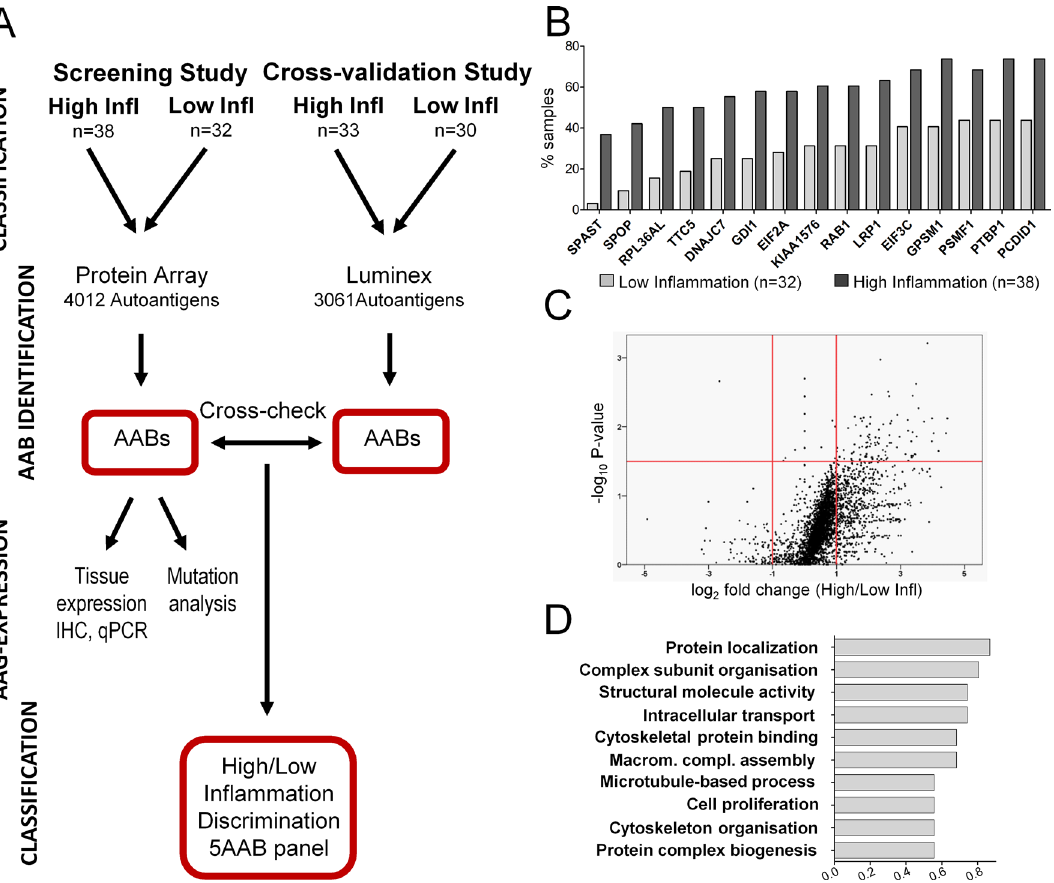
Fig 1. Chronic prostatic inflammation induces elevated autoantibody levels. A Flow chart of the strategy used for the detection and cross-validation of autoantibody (AAB) signatures associated with chronic prostatic inflammation. Radical prostatectomy specimens were classified into two (high/low inflammation) groups based on the extent of immune cell infiltrations in the whole prostate. The corresponding pre-surgery blood serum samples were analyzed for autoantibodies (AAB) using a planar protein array (screening, n = 70). A cross-validation study testing the robustness of the identified AAB panel was based on the Luminex-bead protein array technology (cross-validation, n = 63). Statistical comparison of the serum autoantibody profiles in the low and high inflammation groups was used to identify and validate differentially abundant AABs. The prostate tissue expression patterns and the expression in different prostate cancer progression stages were established for three selected corresponding autoantigens (AAGs). B Bar chart for positively classified observations of the 15 most differentially detected autoantibodies in the high inflammation group compared to the low inflammation group. Data are expressed as percentage of total number of positive samples in each group. C Calculation of the fold change for each autoantibody revealed a significant increase of 165 antigens in high inflammation prostate cancer (upper right panel, p < 0.05, fold change > 2, Mann-Whitney Test) and a decrease of only one (upper left panel). D Graphical representation of the ten top ranked functional clusters assigned for inflammation associated autoantibodies using the DAVID functional annotation tool. The bar size corresponds to the percentage of identified corresponding genes related to a specific functional category (P < 0.05).